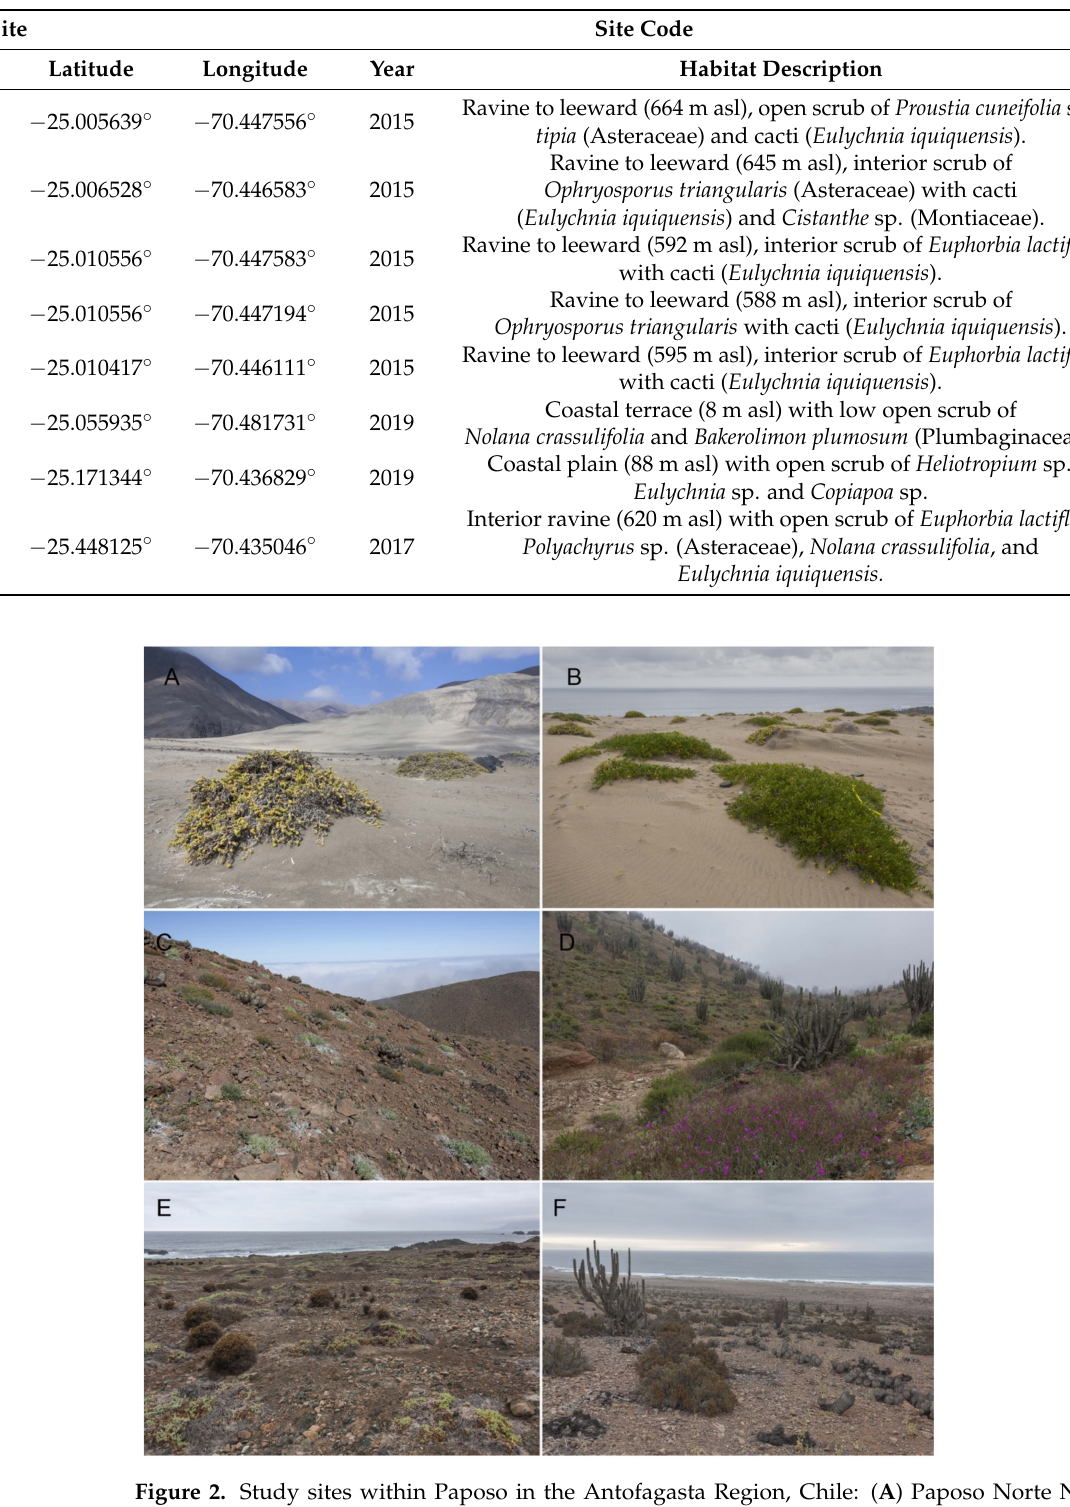
Figure 2. Study sites within Paposo in the Antofagasta Region, Chile: ( A ) Paposo Norte Natu- ral Monument (NPNM) during 2015. ( B ) Paposo Priority Site (coastal dune) (PPSCD1) during 2015. ( C ) Paposo Priority Site (interior ravine) (PPSIR2) during 2017. ( D ) Paposo Priority Site (in- terior ravine) (PPSIR4) during 2015. ( E ) Paposo Priority Site (coastal dune) (PPSCD3) during 2019. ( F ) Paposo Priority Site (Cachinales ravine) (PPSCR) during